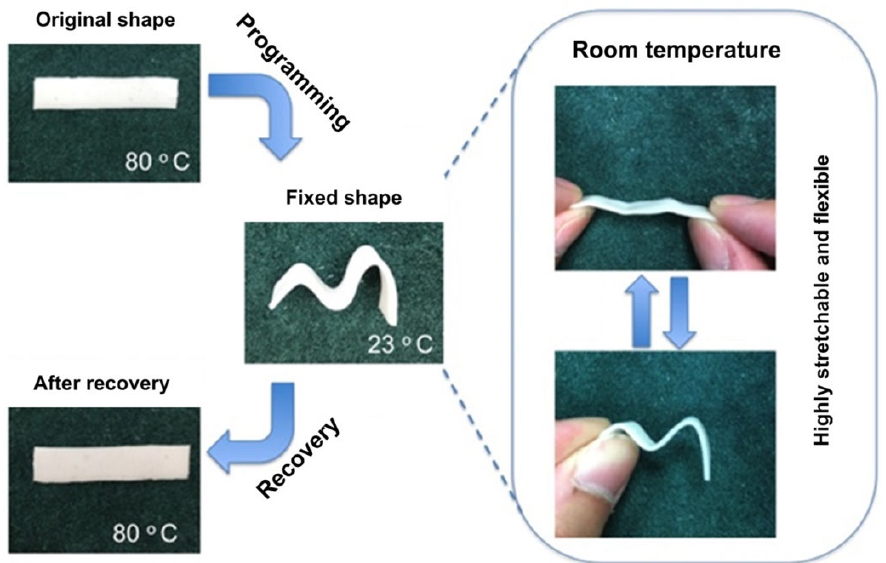
Figure 5. Example behaviour of an SME showed a flat sample in its original state at 80 °C; the sample transformed into a deformed shape at room temperature. After that, heating again to 80 °C resulted in a full return to the original flat shape from the deformed shape. Reprinted from [40], Copyright 2017, with permission from Elsevier.